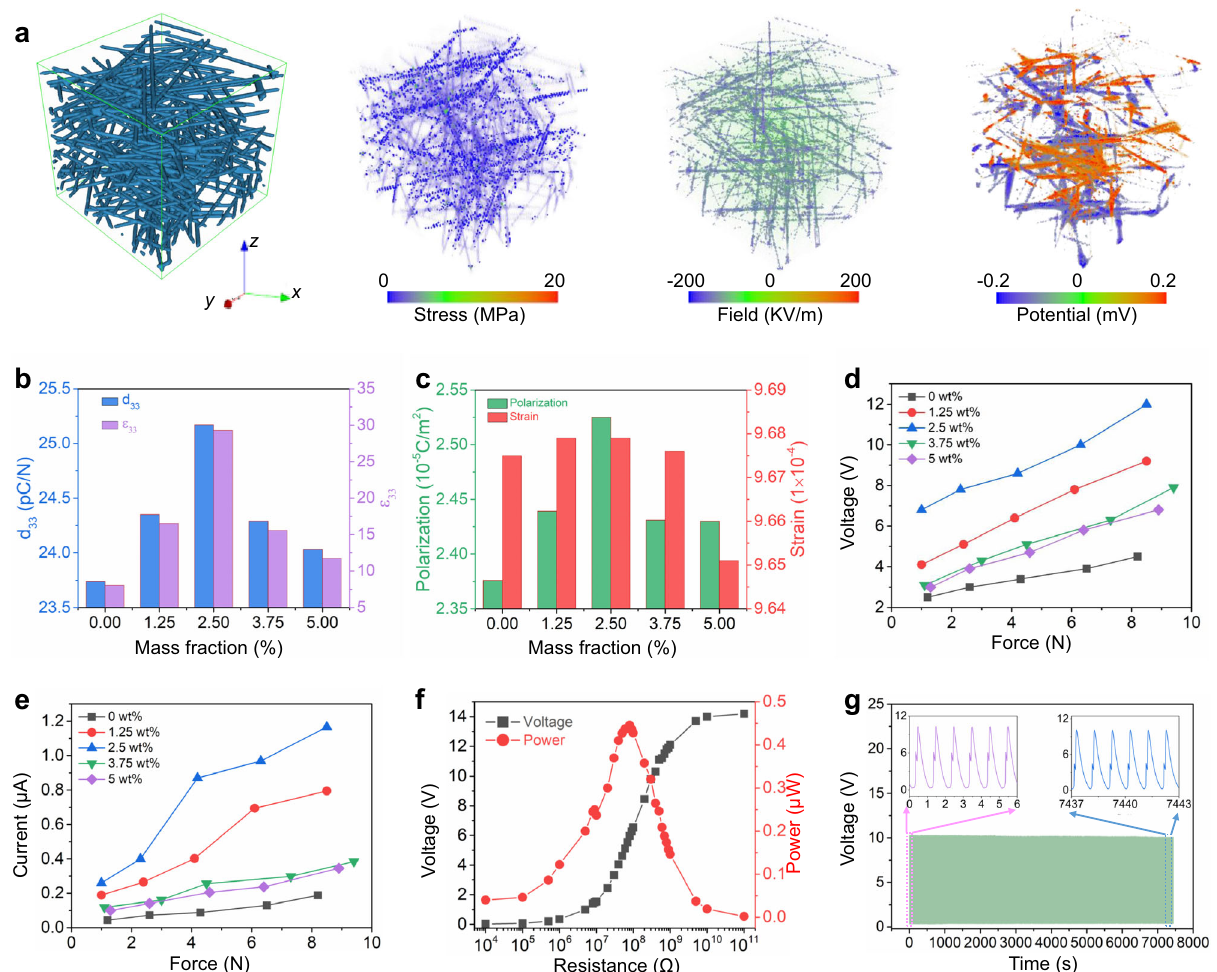
Fig. 5 | Characterization and phase- fi eld simulation results of the as- electrospun textiles. a The visualized structural modeling, stress distribution, electric fi eld distribution, and piezoelectric potential distribution of as-prepared MPC textiles. Note: The applied stress is fi xed at 10 6 Pa along the z -axis for the simulation. b The calculated piezoelectric coef fi cient (d 33 ) and dielectric constant ( ε 33 )oftheas-electrospuntextilesdopedwithvariousMXenemassfractions. c